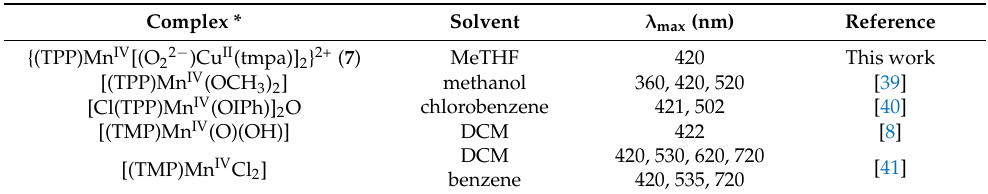
Table 1. Examples of UV-vis absorption features reported for Mn IV complexes bearing TPP-based